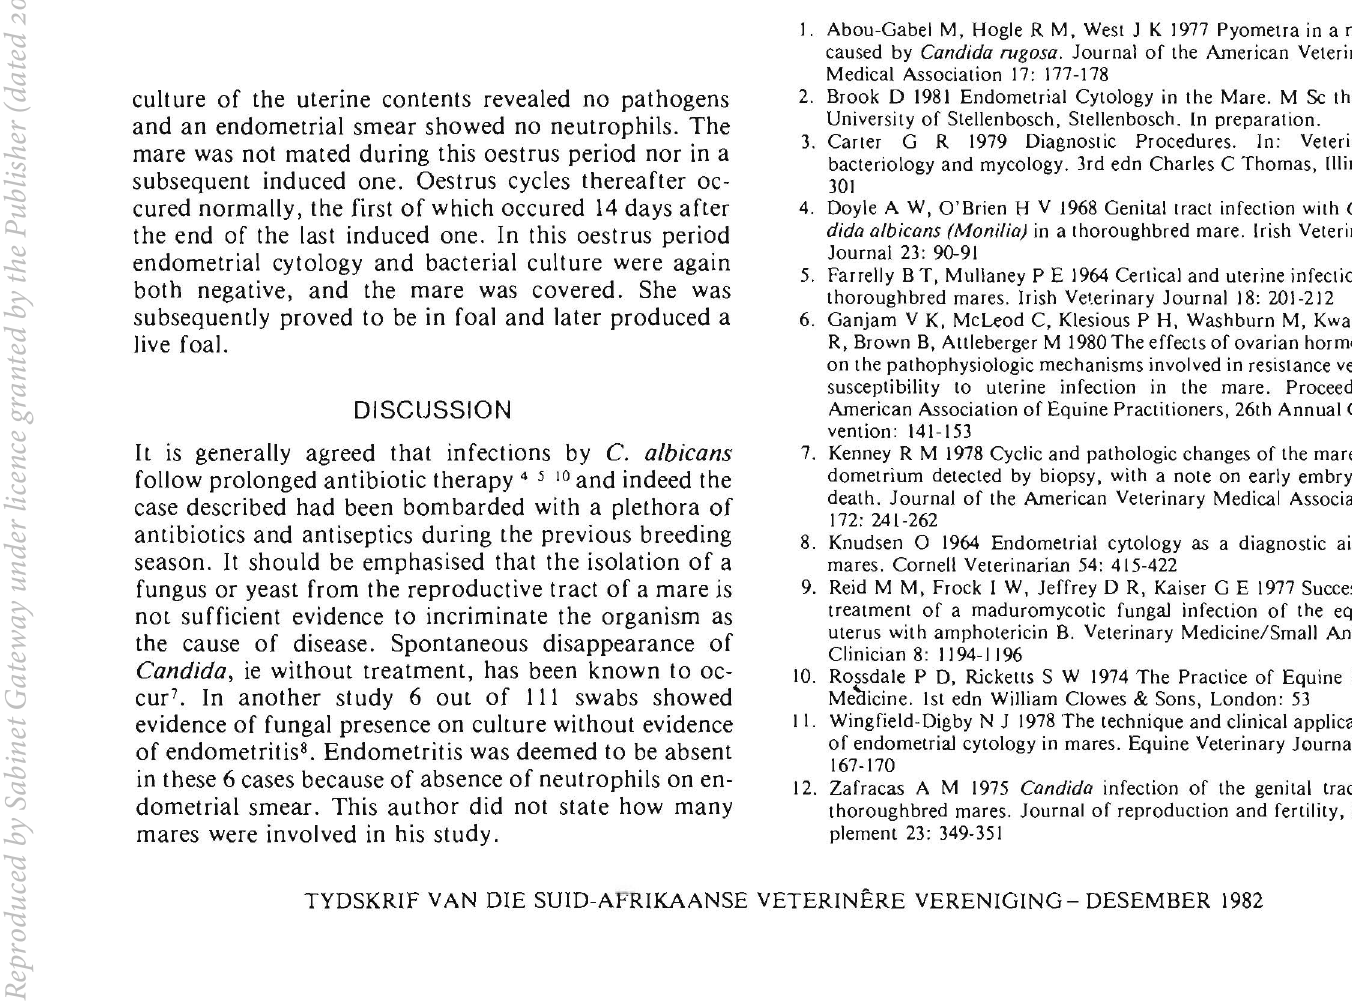
Fig. 2: Endometrial smear showing neutrophils. (x400)